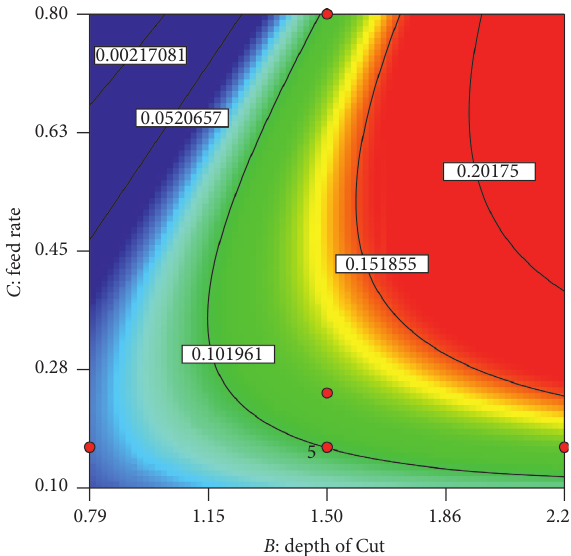
Figure 10: Vibration contour plots (depth of cut vs. feed rate).